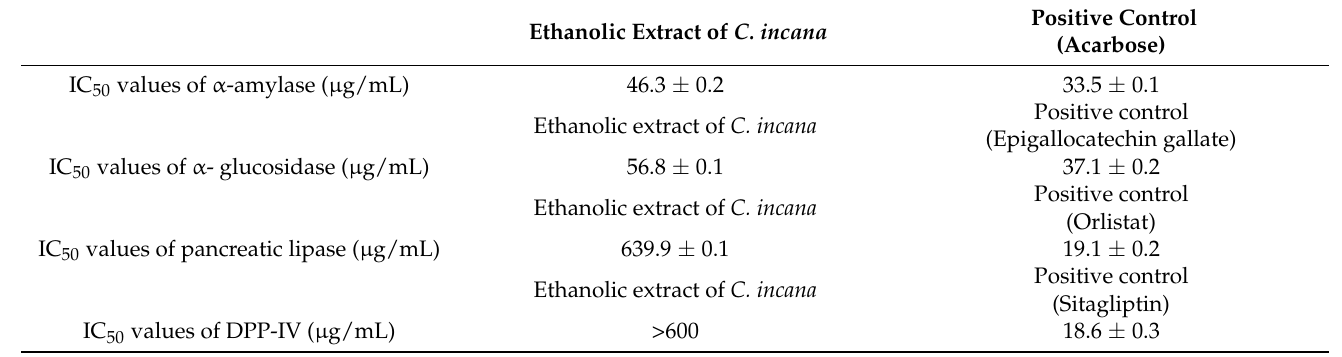
Table 2. α -amylase, α -glucosidase, pancreatic lipase, and DPP-IV inhibitory effects of the ethanolic extract of C. incana, and corresponding positive control IC 50 values ( µ g/mL).